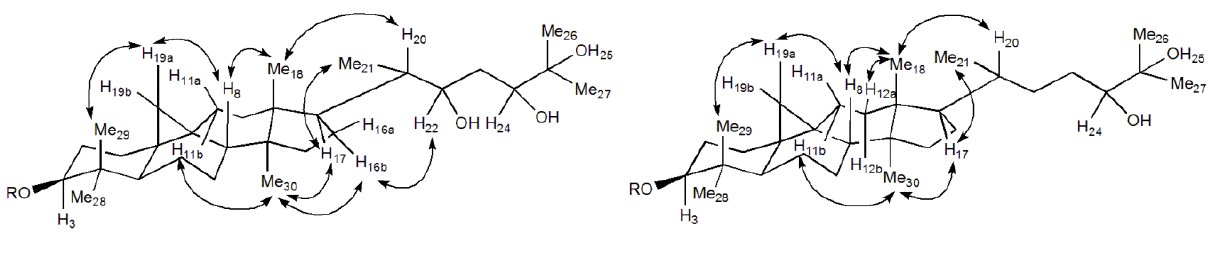
Figure 3. Key NOE correlations of 1 and 2